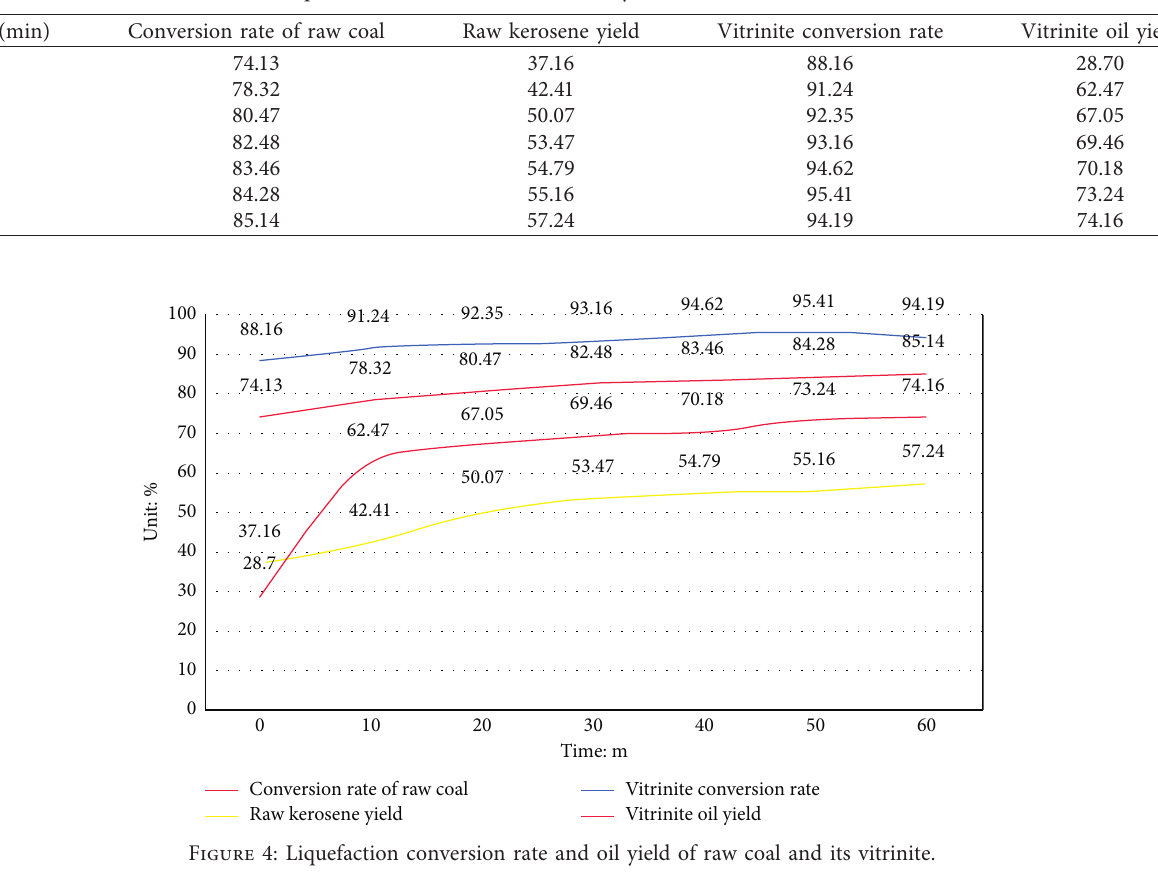
Table 4: Liquefaction conversion rate and oil yield of raw coal and its